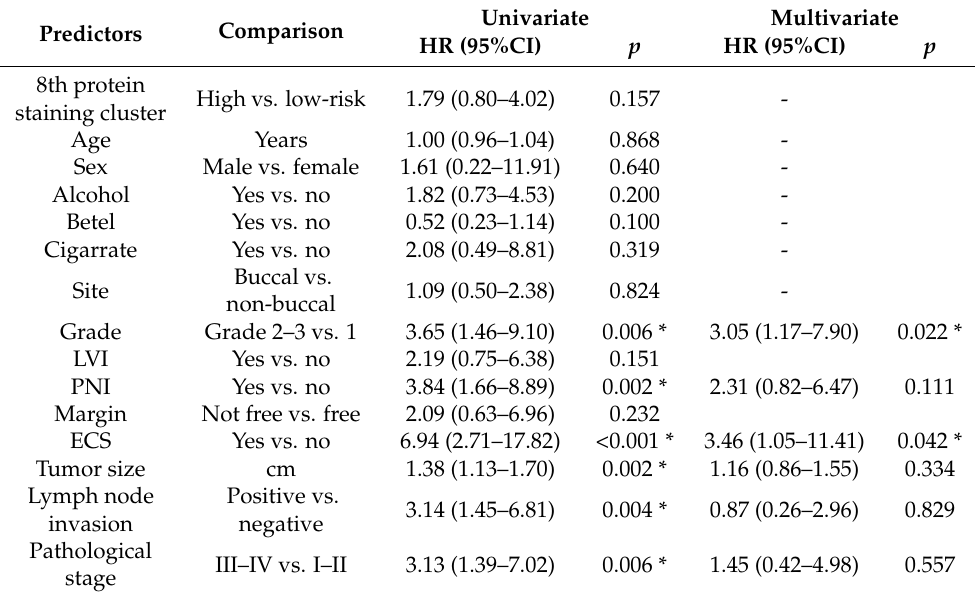
Table 4. Cox proportional hazard regression analysis of overall